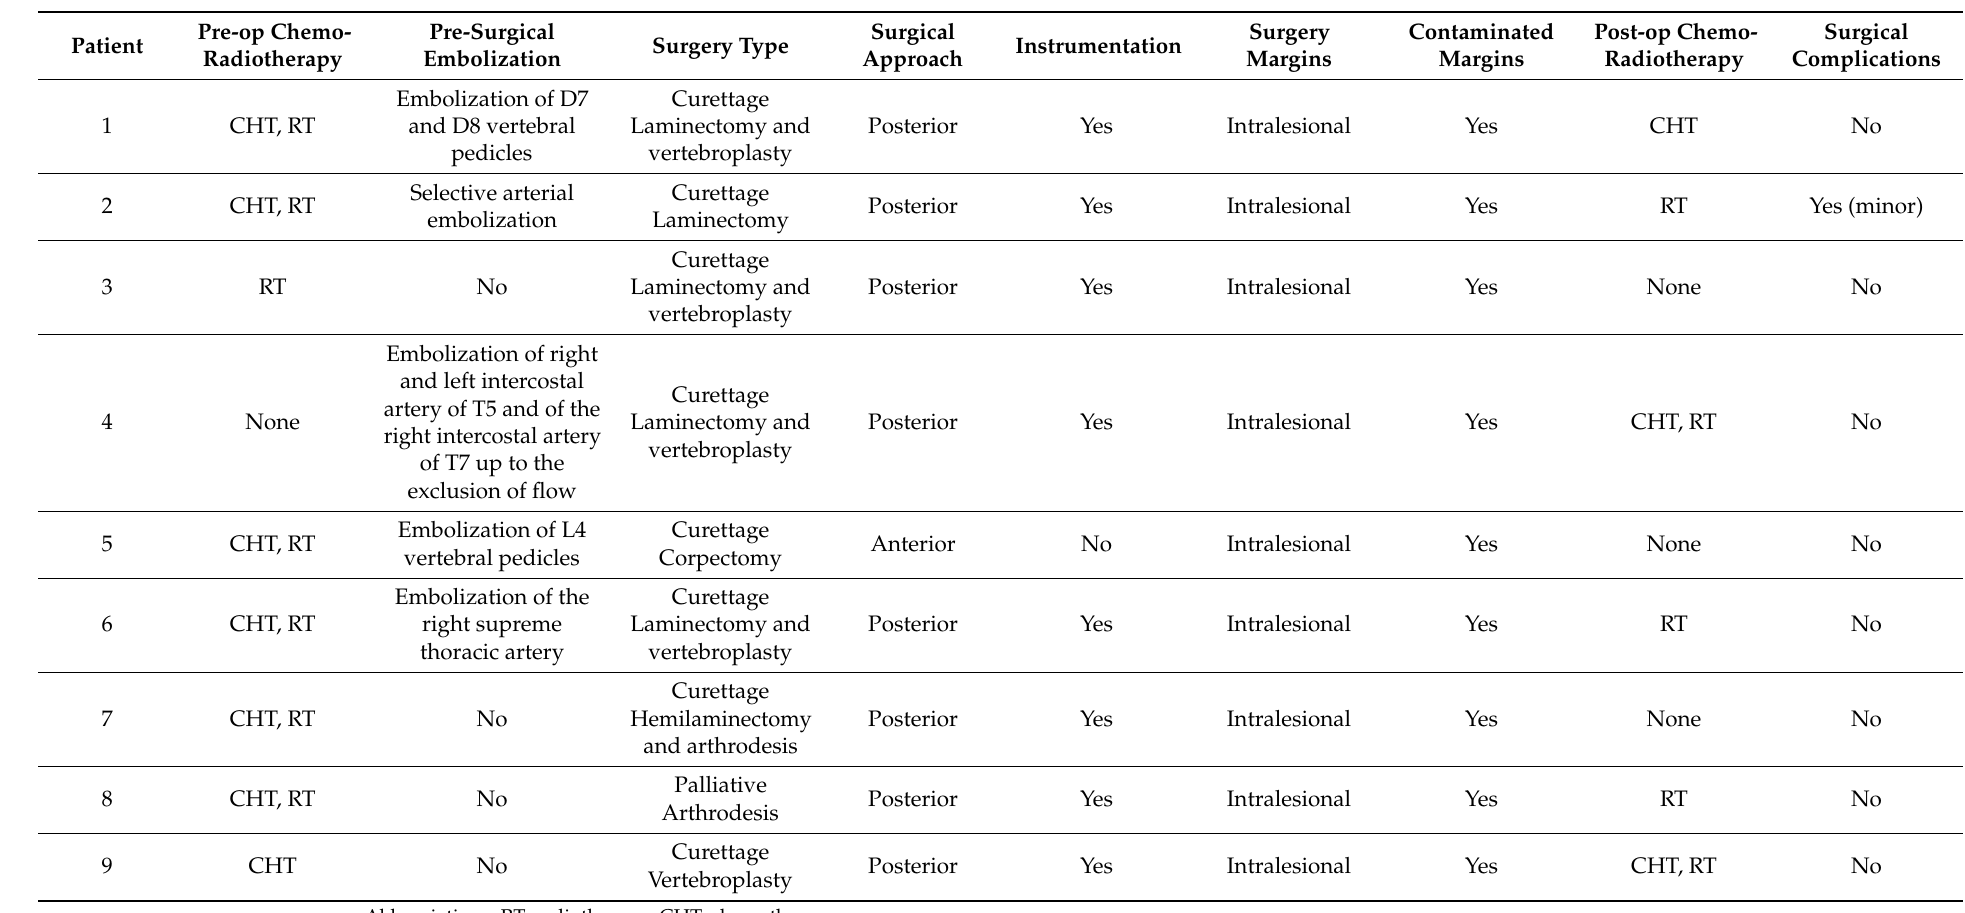
Table 4. LMS spine metastasis surgical approaches (n =